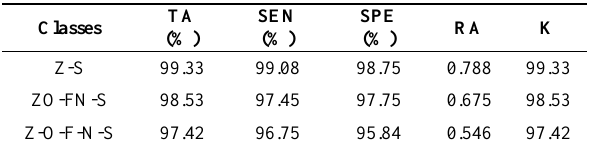
Table 1. TA, SEN, SPE value of three classes of proposed method